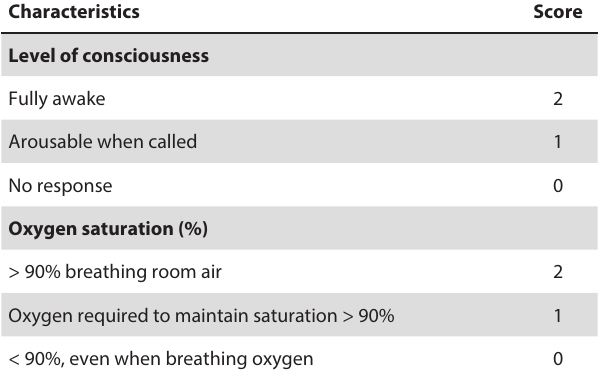
Table 1 : The modified Aldrete scoring system